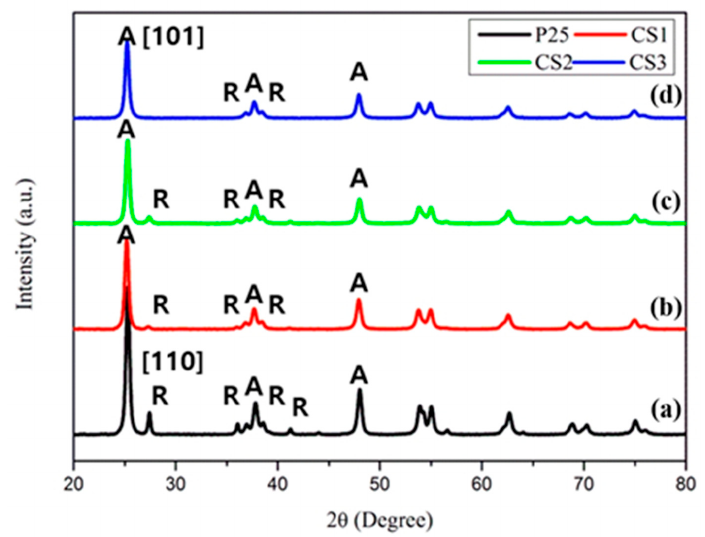
Figure 6. X-ray diffraction (XRD) patterns of P25 and hollow structured titania spheres: ( a ) P25; ( b ) CS1; ( c ) CS2 and ( d ) CS3. Calcination temperature: 700 °C. Table 3. The phase composition and crystallite size of hollow titania spheres.